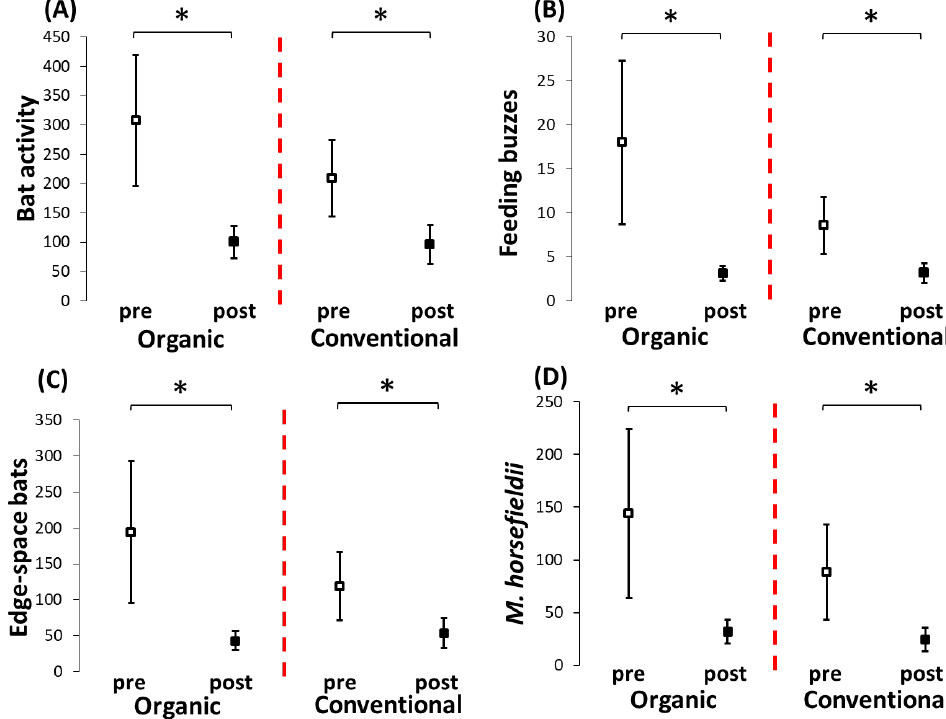
Figure 8. Mean (±SE) values of total bat activity ( A ), total number of feeding buzzes ( B ), activity of edge-space foraging bats ( C ), and activity of M. horsfieldii ( D ) in matched organic and conventional rice fields before (pre) and after (post) tropical storm disturbance. Asterisks indicate significant differences between pre and post tropical storm disturbance ( p < 0.05).